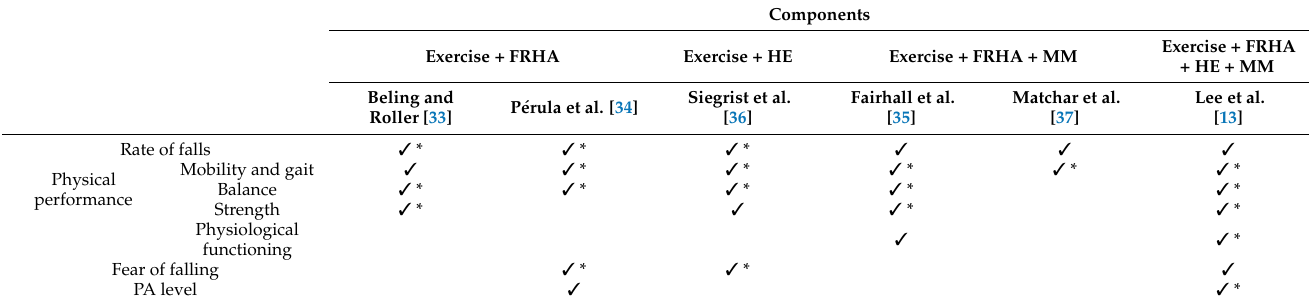
Table 2. Effects of the different types of multifactorial intervention according to their components ( n = 6).